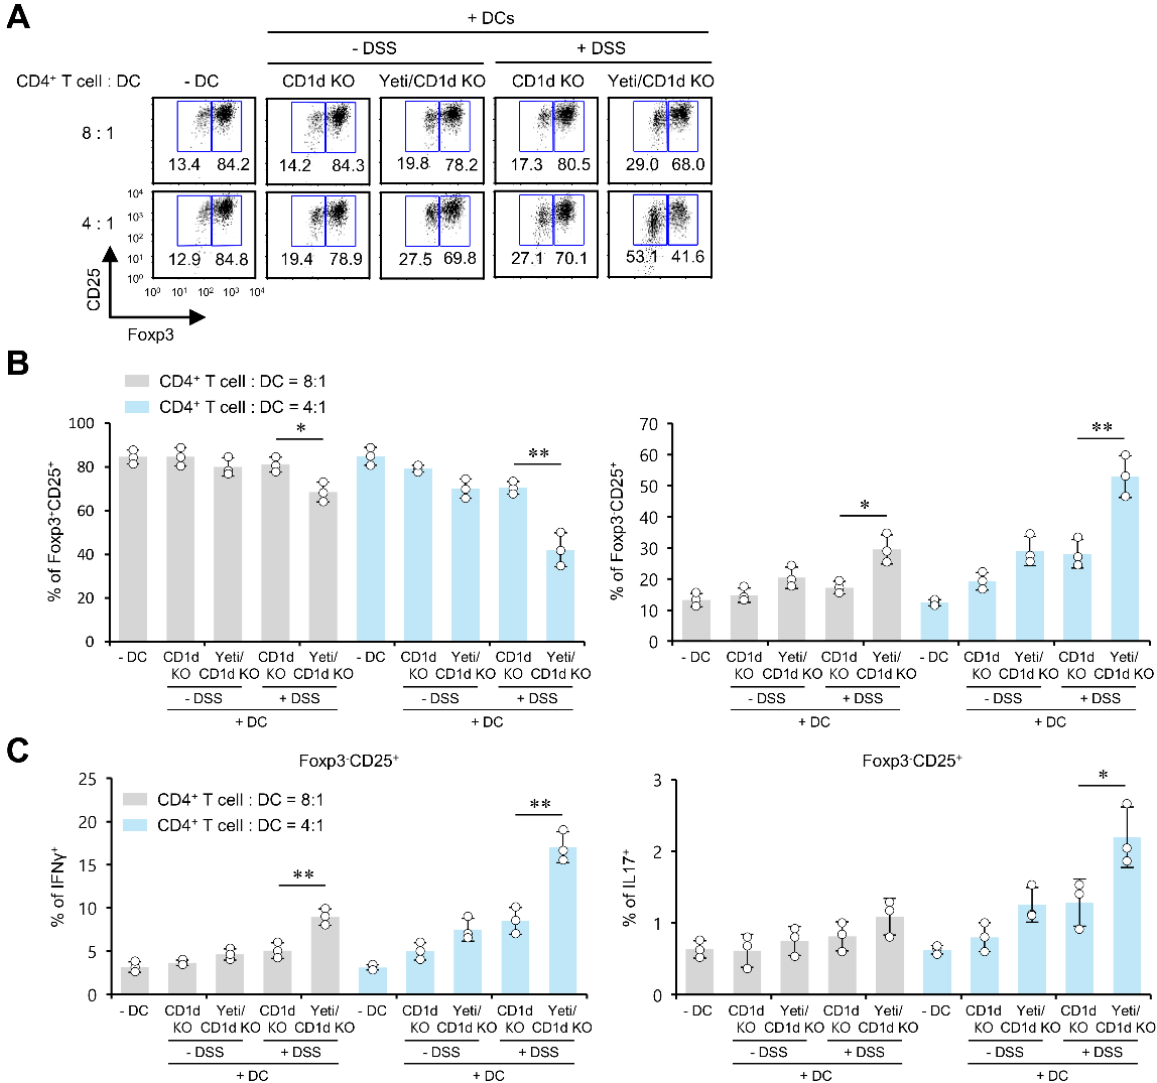
Figure 5. Proinflammatory DCs from Yeti/CD1d KO mice induce the differentiation of Foxp3 − CD25 + CD4 + effector cells and antagonize Treg cell differentiation. ( A – C ) Naive CD4 + CD62L + T cells were isolated from Jα18 KO mice. These naive T cells (1 × 10 5 cells/well) were cocultured under Treg-polarizing conditions with MLN DCs (2.5 × 10 4 or 1.25 × 10 4 cells/well) purified from either CD1d KO or Yeti/CD1d KO mice treated or untreated with 1.5% DSS. ( A , B ) The frequencies of Foxp3 + CD25 + and Foxp3 − CD25 + subsets among CD4 + T cells were analyzed on day 5. ( C ) The intracellular expression of IFN γ and IL17 in Foxp3 − CD25 + CD4 + T cells of each group was analyzed by flow cytometry on day 5. The mean values ± SD ( n = 3; per group in the experiment; Student’s t -test; * p < 0.05, ** p < 0.01) are shown. One representative experiment from two experiments is shown.